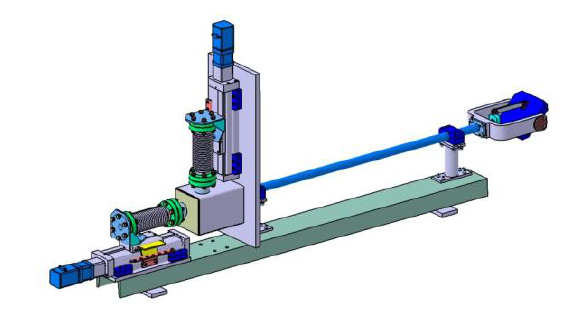
Fig. 7. 3D view of the steering mechanism design